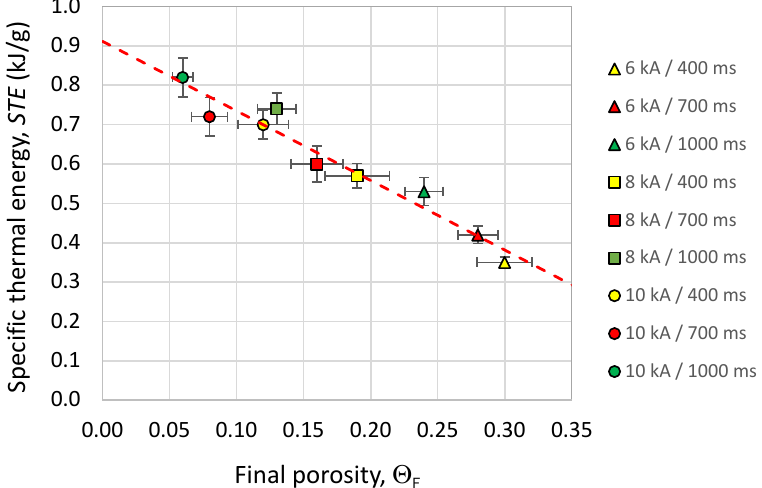
Figure 5. STE vs. final porosity ( Θ F ) for the different MF-ERS compacts, and linear trend obtained by the least squares method.